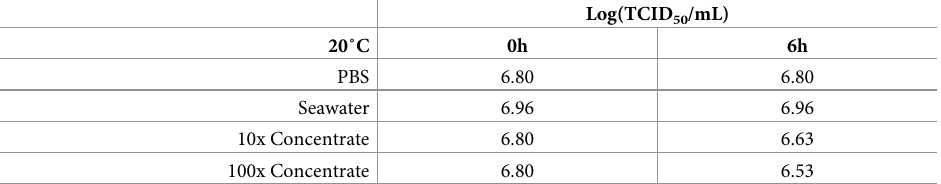
Table 3. PRCV was incubated in seawater media with 1x, 10x, or 100x the natural concentration of suspended sol- ids ( > 100